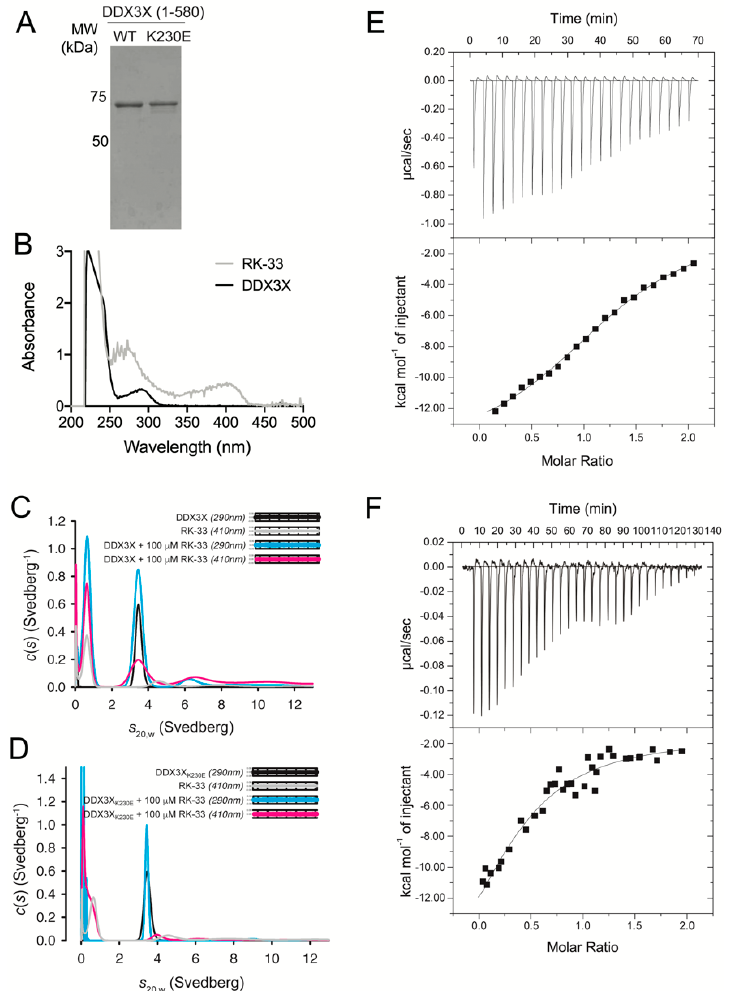
Figure 1. RK-33 directly binds to DEAD-box helicase 3 X-linked (DDX3X) residue K230. ( A ) Coomassie-stained SDS-PAGE of purified recombinant wild-type and K230E DDX3X. ( B ) Wavelength scans of 200–500 nm collected in the analytical ultracentrifuge on purified recombinant DDX3X alone (black) and 100 μ M RK-33 (gray). Sedimentation velocity studies of RK-33 binding to ( C ) DDX3X or ( D ) DDX3X K230E. c ( s ) distributions from fits to data collected at 290 and 410 nm were plotted as a function of s 20,w for DDX3X in the presence of 100 μ M RK-33 at 290 nm (blue) and 410 nm (pink), 100 μ M RK-33 alone (410 nm, gray) and DDX3X with an equivalent % dimethyl sulfoxide (DMSO) (DDX3X alone, 290 nm, black). The residual plots are shown in insets. Data in ( C , D ) are each representative of two independent experiments. ( E , F ) Calorimetry studies of RK-33 binding to DDX3X. RK-33 at ( E ) 50 μ M and ( F ) 200 μ M was injected into DDX3X (17 μ M) in the sample cell. Data were fit to a one-site binding model. The stoichiometry deduced from data fitting to the two experiments was 1.05 ± 0.2, with a K d of 33 ± 2 μ M and Δ H of − 19 ± 0.3 kcal/mol. Reported values represent the average of the two experiments, with average errors of the fits to the experimental data reported by Origin 7.0.